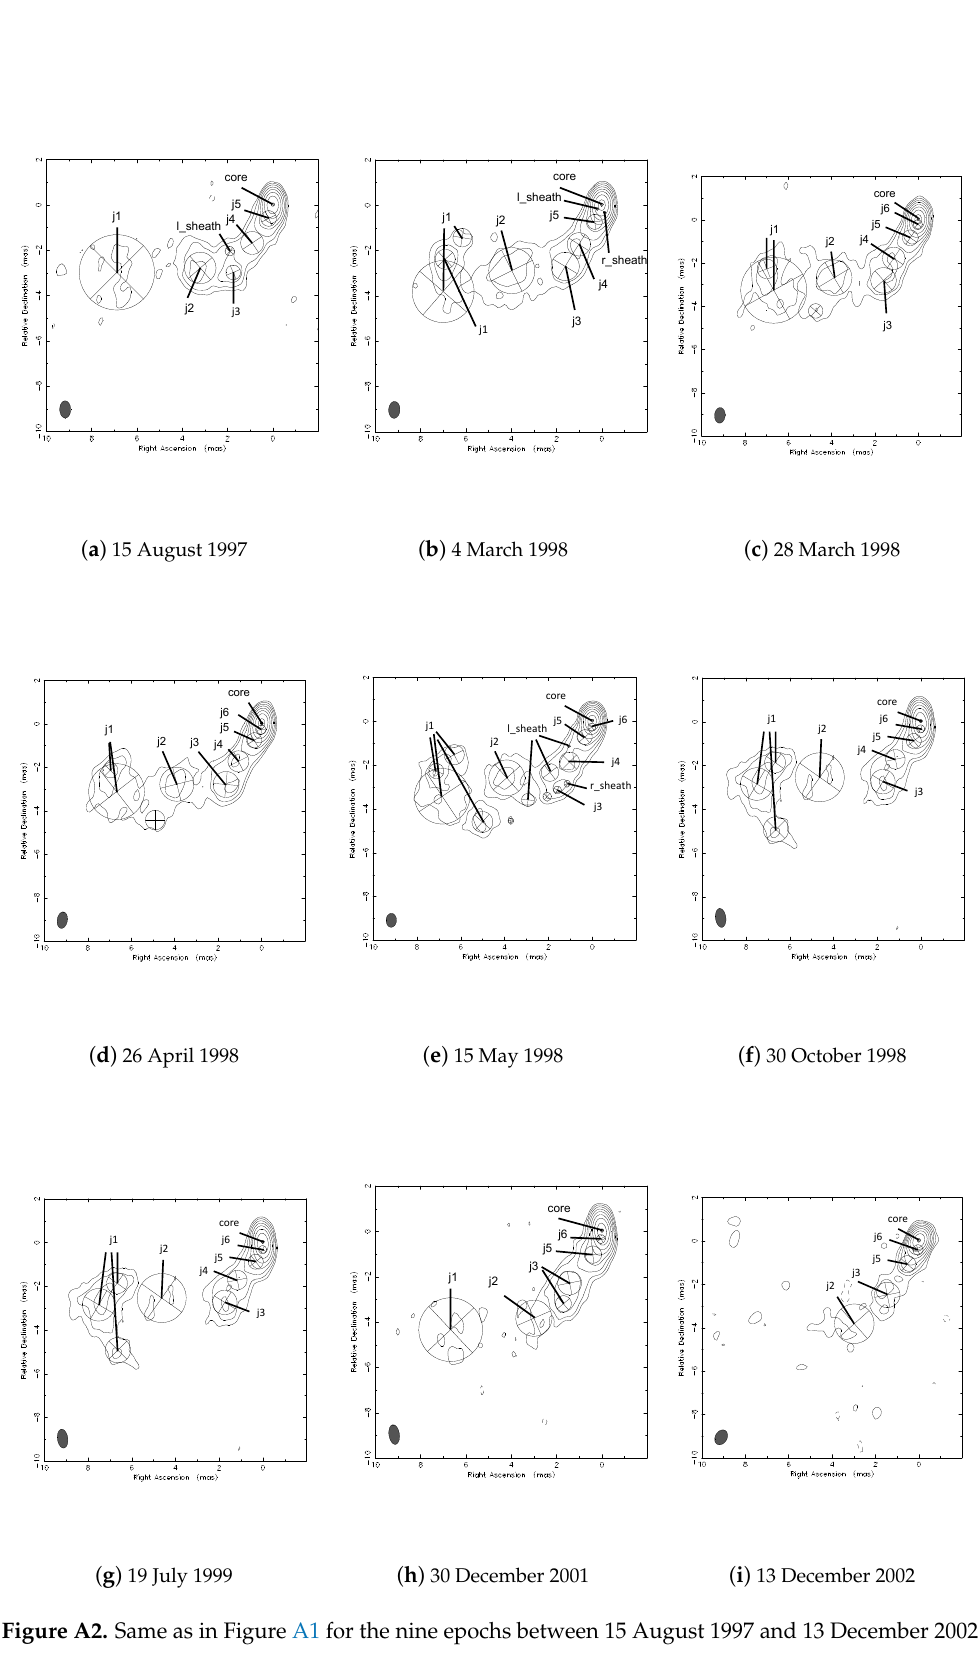
Figure A2. Same as in Figure A1 for the nine epochs between 15 August 1997 and 13 December